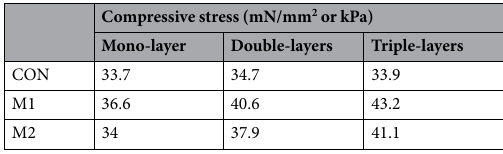
Table 2. Compressive stress of